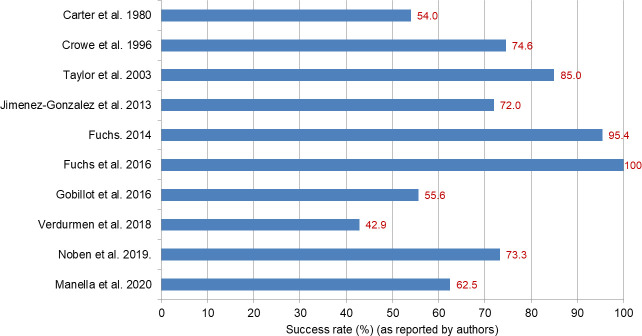
Success rates of unnamed fetal electrocardiography devices.Success rates presented as reported by the authors.